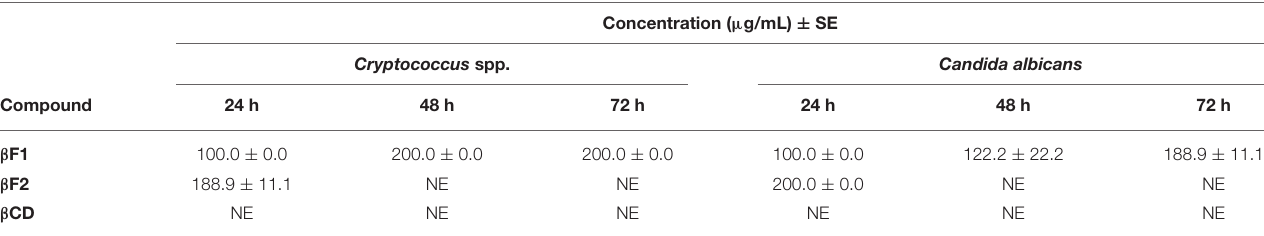
TABLE 6 | Minimal inhibition concentration ( µ g/mL) of tested compounds included in β CD